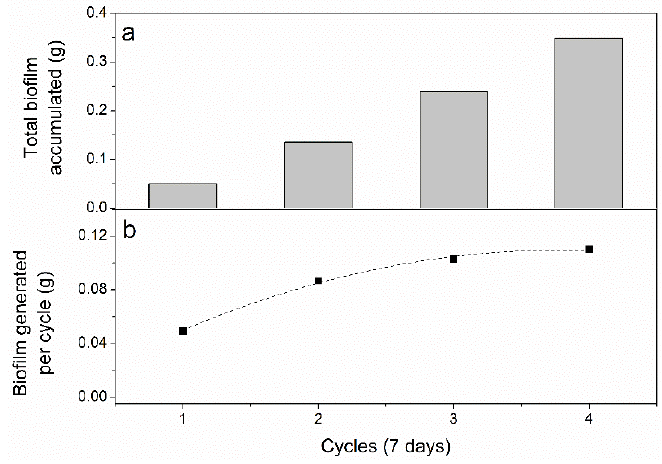
Figure 1. Evidence of active microbial growth over the cathode surface during the bioelectrochemical experiments, as indicated by ( a ) accumulated biomass at the end of each seven-day cycle, and ( b ) biomass generated in each cycle.